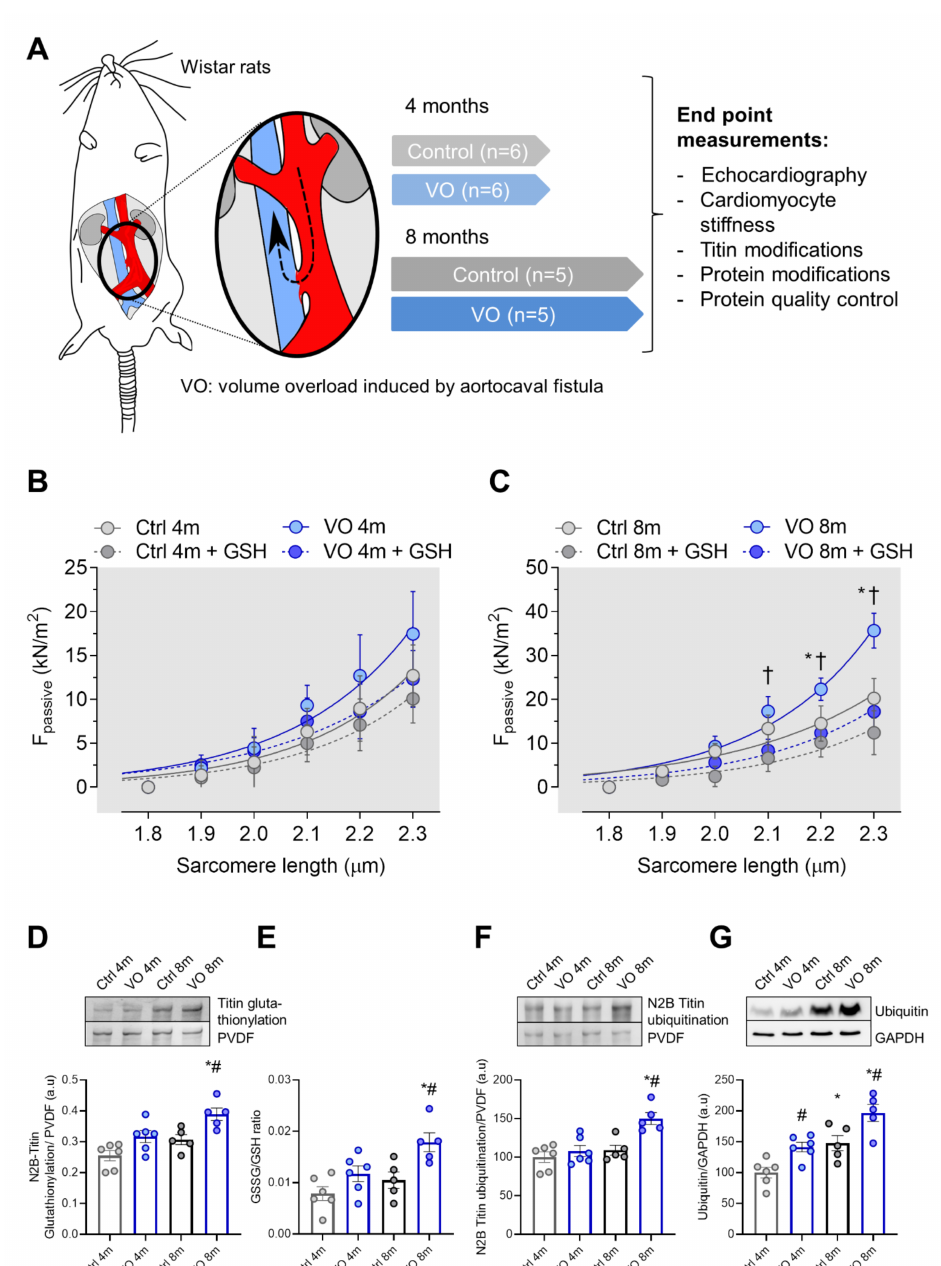
Figure 1. Protocol figure and titin oxidation and ubiquitination. ( A ) Experimental set-up, male Wistar rats were subjected to aortocaval fistula to develop volume overload-induced hypertrophy, ( B ) passive tension–sarcomere length relations of control (Ctrl) and volume overload (VO) cardiomyocytes in 4-month group with or without GSH treatment at sarcomere length (SL) 1.8–2.3 µ m. ( C ) Passive tension–sarcomere length relations of control (Ctrl) and volume overload (VO) cardiomyocytes in 8-month group with or without GSH treatment at sarcomere length (SL) 1.8–2.3 µ m. All force recordings were normalized for cardiomyocyte cross-sectional area. Curves represent third-order polynomial regressions. Data are shown as nonlinear regression fit of the means/medians; n = 5–6. * p < 0.05 Ctrl vs. VO 8-month, † p < 0.05; 8-month VO + GSH vs. 8-month VO, using one-way ANOVA Tukey multiple comparisons test. ( D ) S-glutathionylation of N2B-titin from left ventricular tissue. ( E ) GSSG/GSH ratio, ( F ) ubiquitination of titin, ( G ) ubiquitin level. Data are shown as mean ± SEM; n = 5–6. # p < 0.05 Ctrl vs. VO.; * p < 0.05 4-months vs. 8-months using one-way ANOVA Tukey multiple comparisons